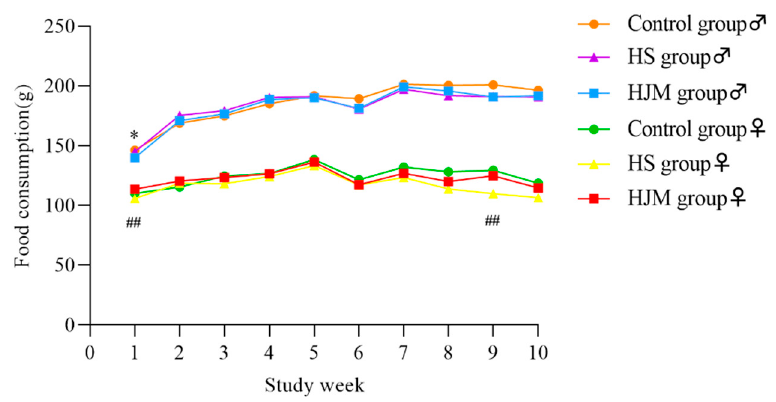
Figure 3. Mean weekly food consumption of male and female rats.